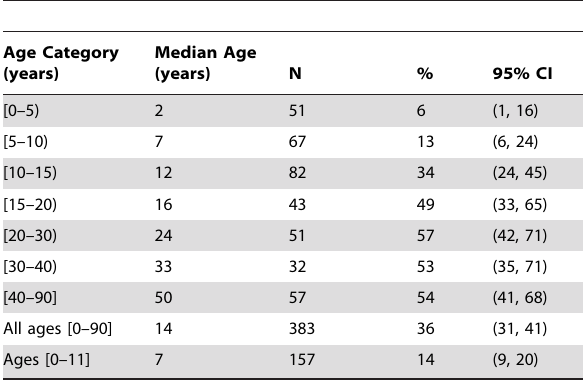
Table 2. Age-specific seroprevalence estimates based on the MSP-1 19 antibody in Miton, Haiti in